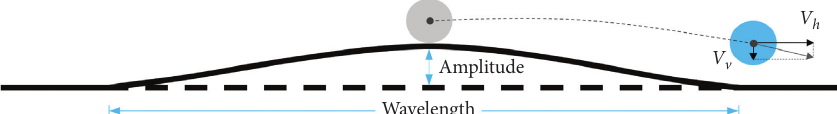
Figure 3: Diagram for the wheel running through the irregularity